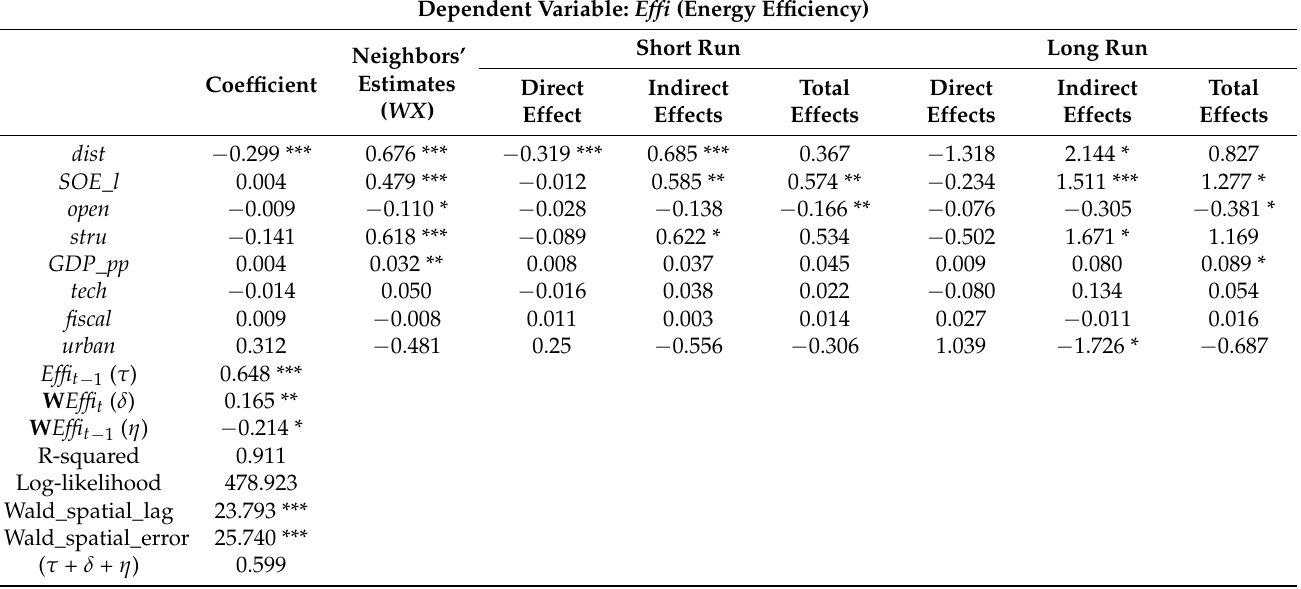
Table 3. Estimation results of the dynamic